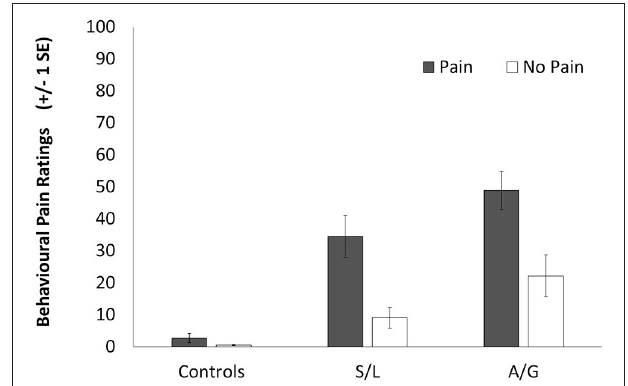
FIGURE 2 | Subjective ratings for the pain (filled bars) and no-pain (empty bars) stimuli. A score of 100 indicates a high perception of pain in the participant in response to the observation of pain and a score of 0 represents no perception of pain. Error bars show ± 1